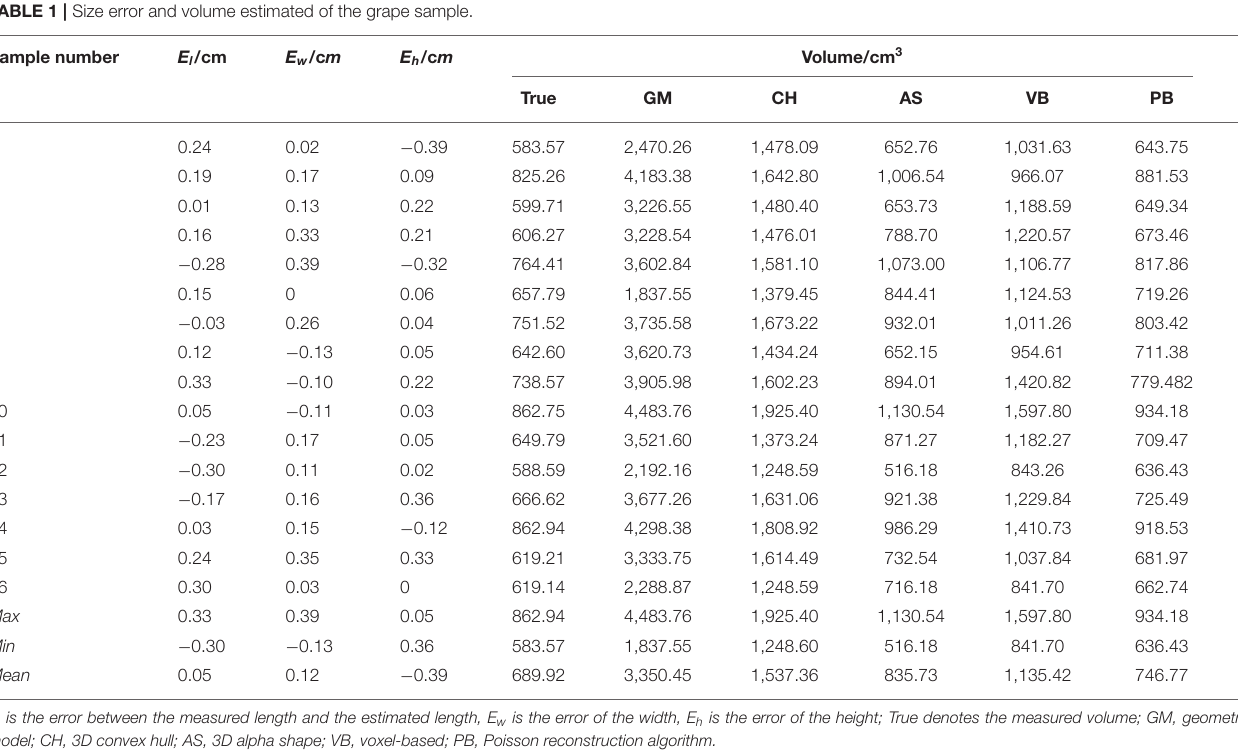
TABLE 1 | Size error and volume estimated of the grape sample.